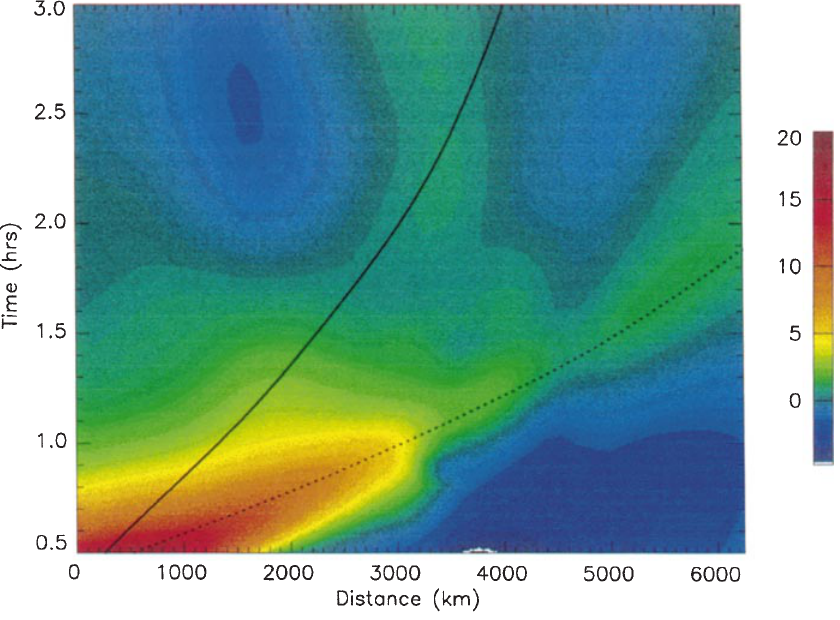
Fig. 6. Colour contour plot of the time history of the temperature perturbation on pressure level 13 along the approximate path of the pressure level disturbance. The horizontal axis indicates the distance from the throat along the path indicated in Fig. 5. The vertical axis indicates the time in hours after 1900 UT. The solid and dotted lines indicate the motion of a disturbance travelling at the neutral wind speed and at a velocity of 750ms (cid:255) 1 relative to the neutral gas respectively